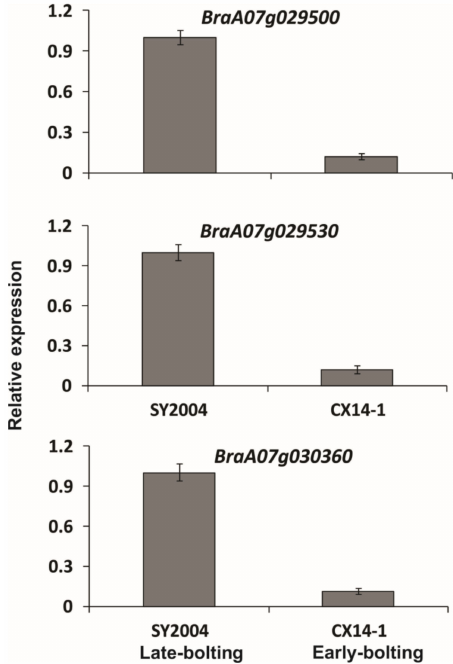
Figure 7. Relative expression of three genes in the leaves of early- and late-bolting Chinese cabbage double haploid lines. Error bars represent ± SE of the means of the four techniques with three biological